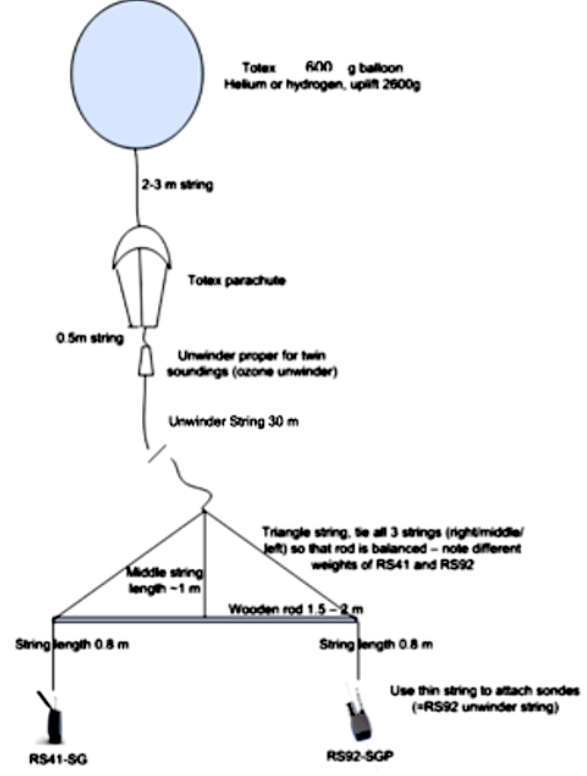
Figure 3. Experimental setup: balloon, parachute, unwinder, rig- ging, and